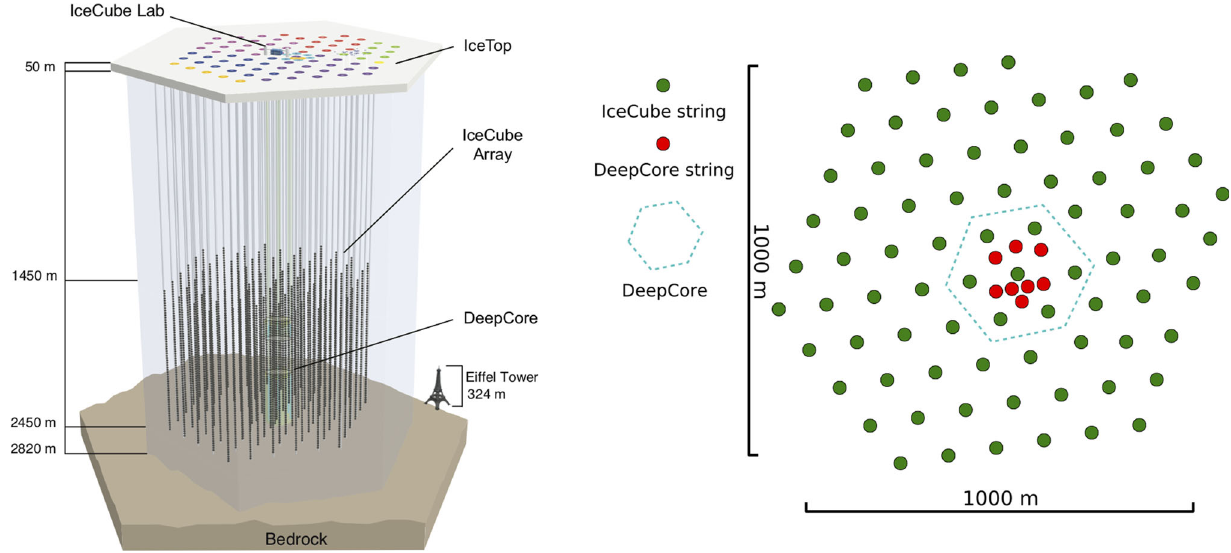
Fig. 1 Sketch of the IceCube observatory. The right plot shows the surface footprint of IceCube. The green circles represent the stan- dard IceCube strings, separated by 125 m, and the red ones the more